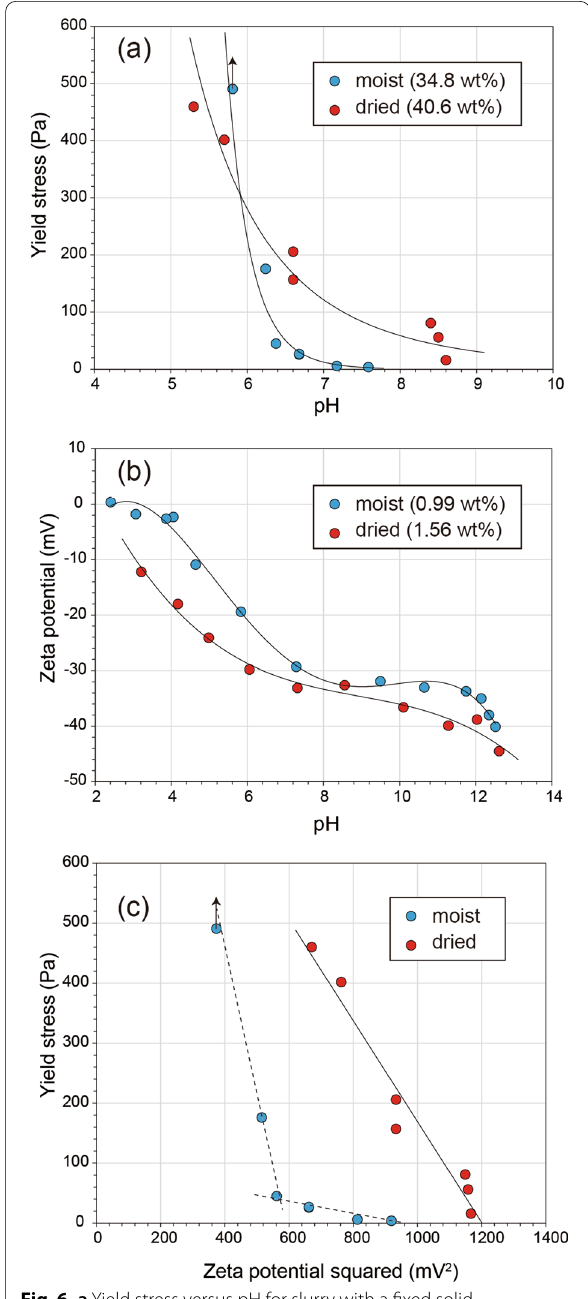
Fig. 6 a Yield stress versus pH for slurry with a fixed solid concentration of 34.8 wt% moist soil (blue) or 40.6 wt% dried soil (red). b Zeta potential with respect to pH: slurry with 0.99 wt% moist soil (blue) or 1.56 wt% dried soil (red). c Yield stress versus zeta potential squared. The zeta potential at each pH is derived from a polynomial fit of the zeta potential data in